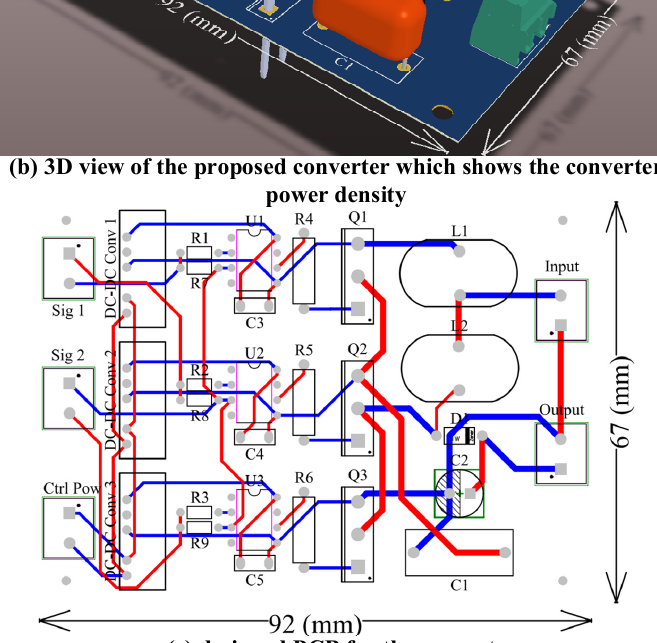
Figure 10. The constructed prototype and considered industrial version.